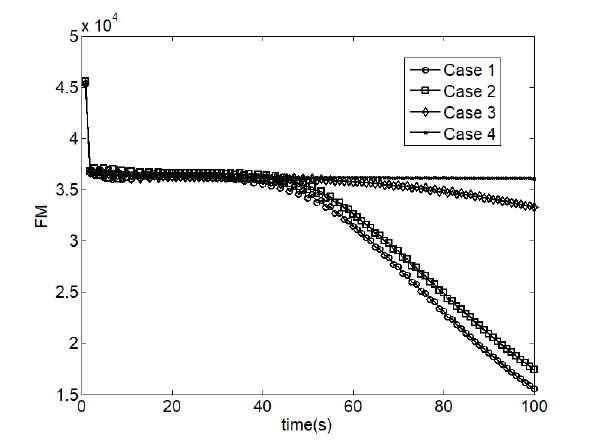
Figure 5. FM of different excitation